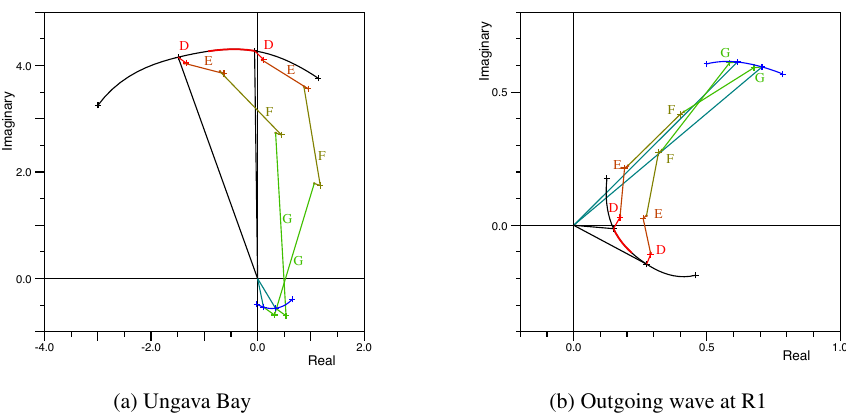
Figure 10. In black: real and imaginary components of the response function (a) on the west side of Ungava Bay and (b) the outgoing wave at point R1 on the open boundary, plotted for real values of angular velocity between 11 and 14 rad / day . Coloured vectors indicate the contributions of the resonances D to G of table 2 and their conjugates. The blue line is the residual background. The red section of the main curve corresponds to the semi-diurnal tides.